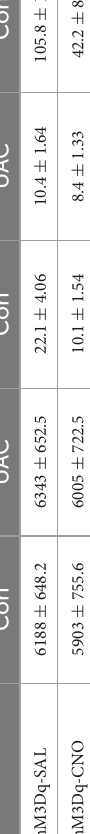
bilaterally injected into the Vpdm of VGLUT1-IRES-Cre mice ( Figure 3B ). After the hM3D (Gq) incubation and 2 weeks of UAC, the mice were injected with saline or CNO (3 mg/kg) and evaluated using the OFT and the EPM. The